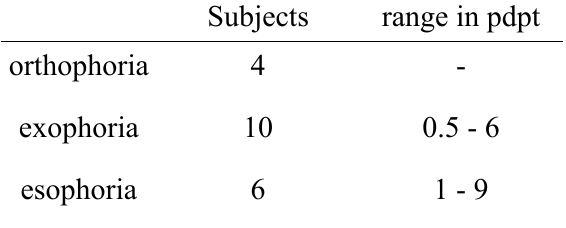
Table 5: Distribution of dissociated phoria (40cm)